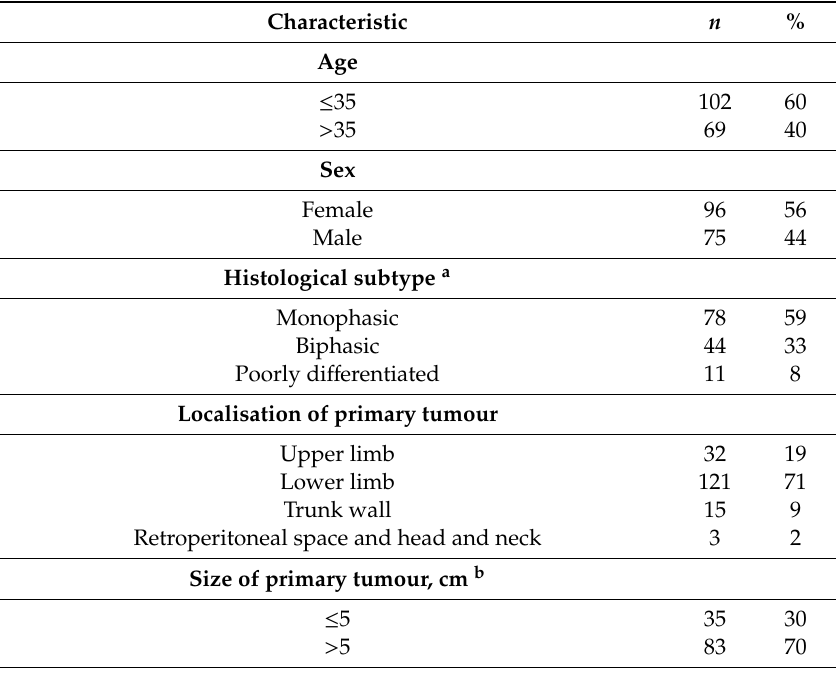
Table 1. Characteristics of patients with locally advanced synovial sarcoma ( n =